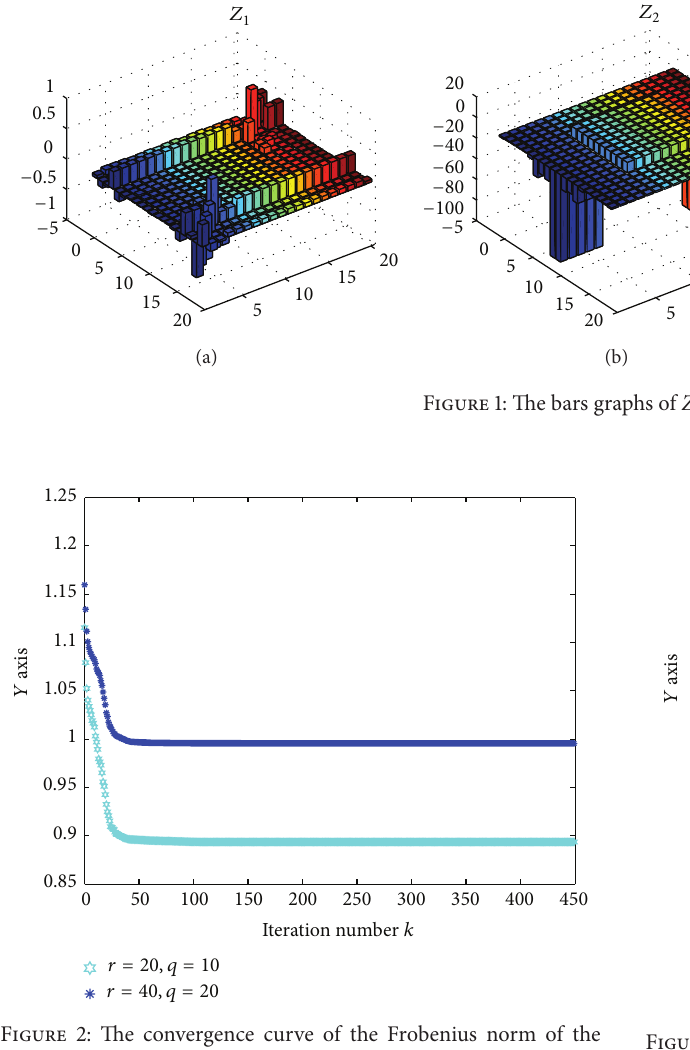
Figure 3: The convergence curve of the Frobenius norm of the terminated